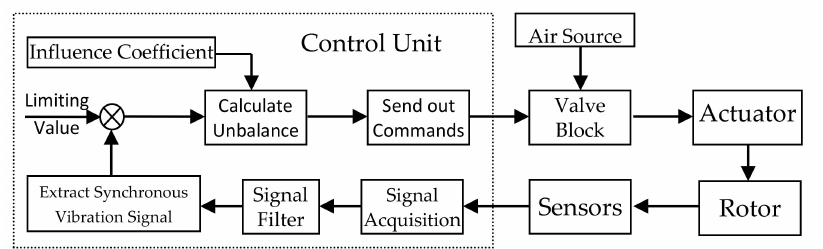
Figure 7. Block diagram of the control